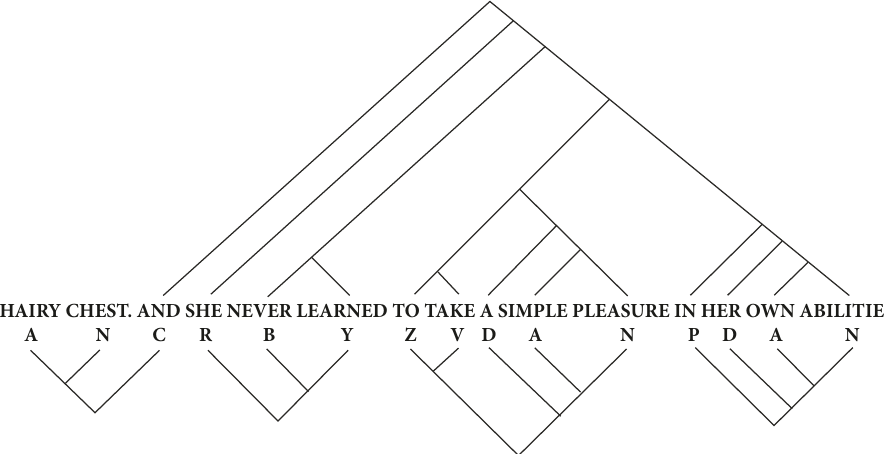
Figure 15: One sentence from a 7600-word sample from the book Jerusalem the Golden (by Margaret Drabble) showing (above the text) a surface structure analysis and (below the text) the parsing developed by the MK10 Computer Model at a late stage of processing. Reproduced from Figure 7.4 in [98], with